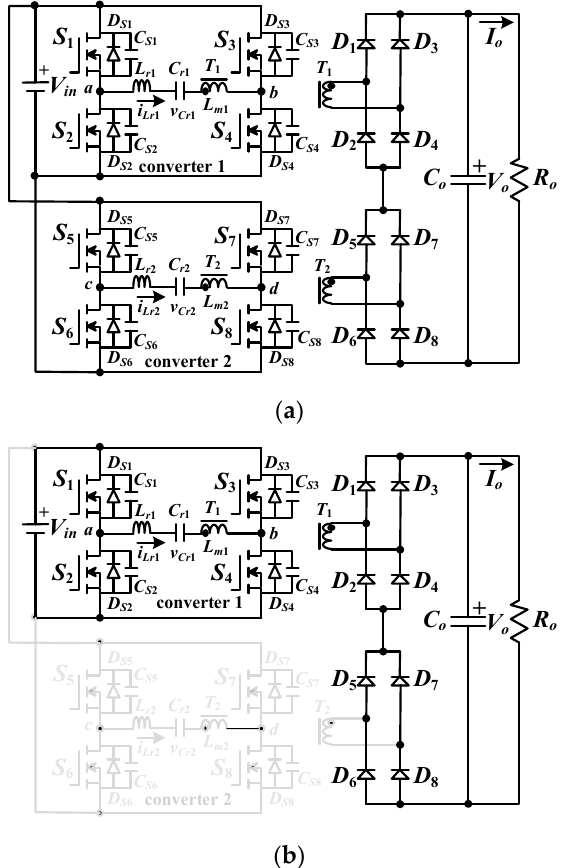
Figure 1. Circuit configuration of the studied circuit ( a ) for high-voltage output operation, and ( b ) for low-voltage output operation.